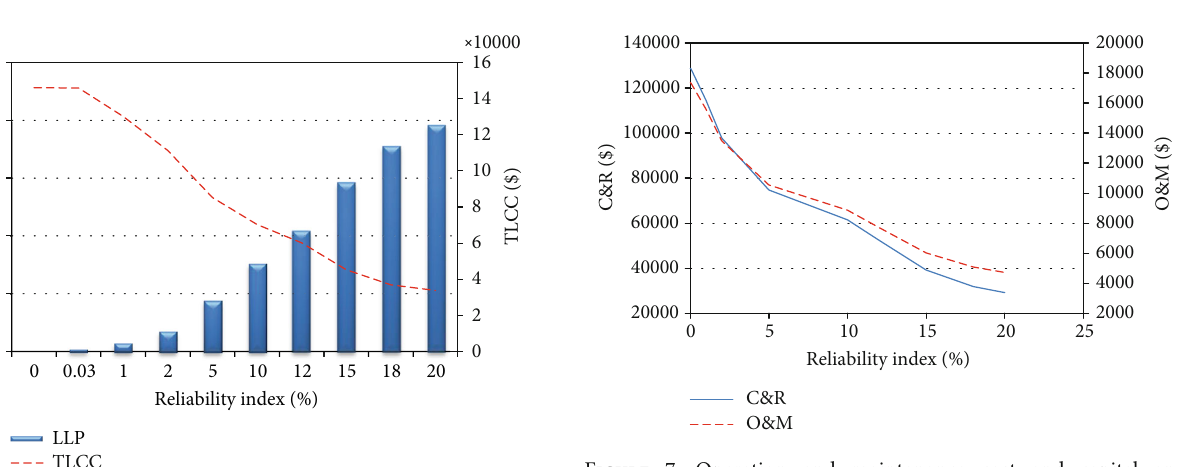
Figure 7: Operation and maintenance cost and capital and replacement cost vs. reliability indexes in the optimal condition.